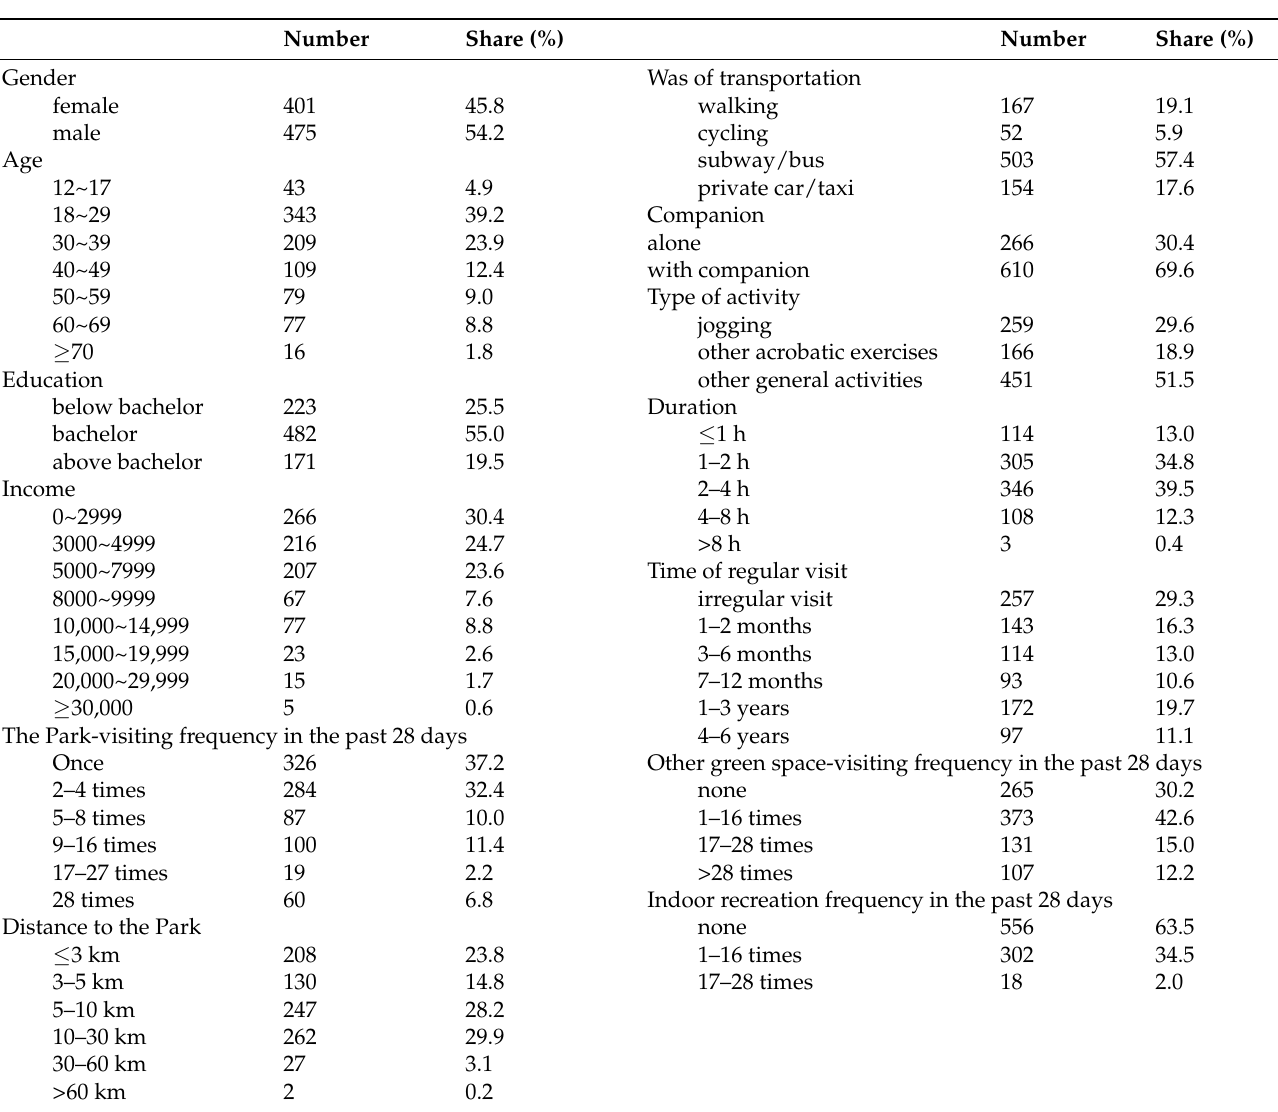
Table 3. Profile of the sample ( n =